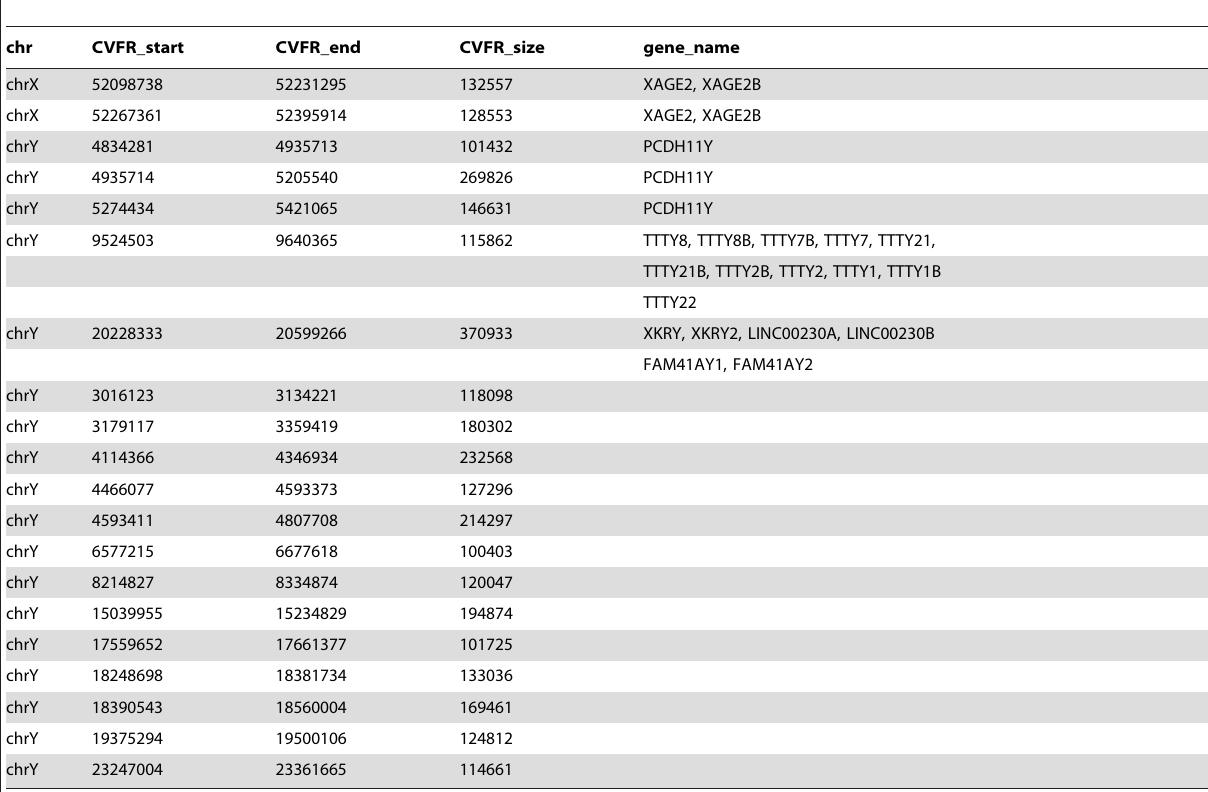
Table 3. List of 20 common variant-free regions containing 20 genes.